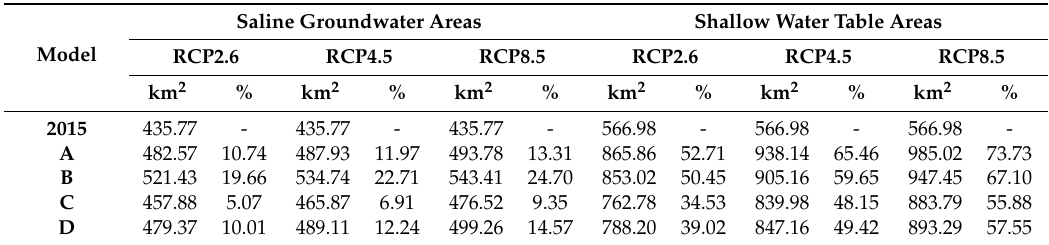
Table 6. Projected groundwater salinity and shallow water table distribution areas under future climate scenarios and different conceptual